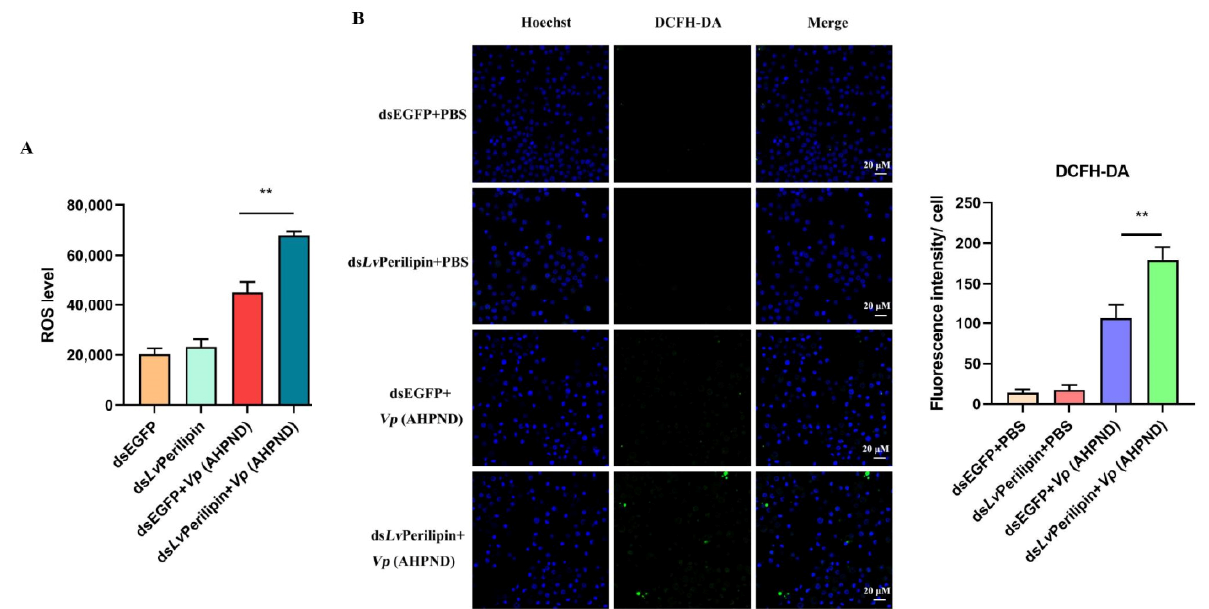
Figure 5. The effect of Lv Perilipin on the production of ROS in shrimp hemocytes upon Vp (AHPND) infection. ( A ) DsEGFP (control group) and ds Lv Perilipin (experimental group) were injected into shrimp. The two groups were then injected with PBS (negative control) or 1 × 10 5 unit Vp (AHPND). After 12 h post- Vp (AHPND) injection, the shrimp hemocytes were labeled by DCFH-DA. The samples were detected using a microplate reader at 488 nm excitation wavelength and 525 nm emission wavelength. ( B ) The ROS levels of shrimp hemocytes were detected using a confocal laser-scanning microscope. Representative images are displayed. Scale bar = 20 μ m. Statistical significance was set at ** p < 0.01.